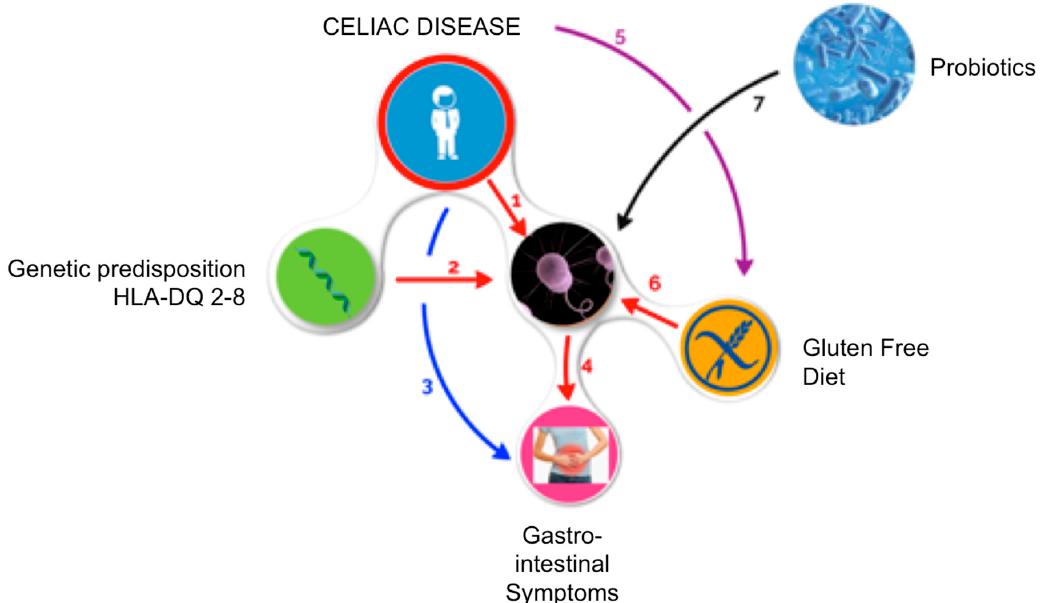
Figure 1. Mechanism of action of probiotics in controlling GI symptoms in celiac patients. Recent data have shown that patients with celiac disease (CD) have an altered gut microbiota (GM), (1) and that carrying the genetic predisposition (HLA-DQ-2 or DQ-8) may predispose individuals to a state of dysbiosis. (2) Patients with CD usually have GI symptoms (3) that can persist to a strict gluten-free diet (GFD); moreover, the alteration of GM can be one of the main causes of the persistence of GI symptoms. (4) CD requires that a patient follow a rigorous GFD (5) and a natural reduction in polysaccharide intake (fructans), which have prebiotic action, and constitute one of the main energy sources for commensals of the GM that might further worsen gut dysbiosis. (6) In turn, this reinforces the persistence of GI symptoms. (7). If we consider that most of the variables of this complex equation are fixed (genetic predisposition, CD, need for a GFD, the presence of GI symptoms), the only variable on which we can operate is the GM: therefore, the adoption of a probiotic supplementation that restores the imbalance in the GM of a celiac patient might be a reasonable therapeutic option.